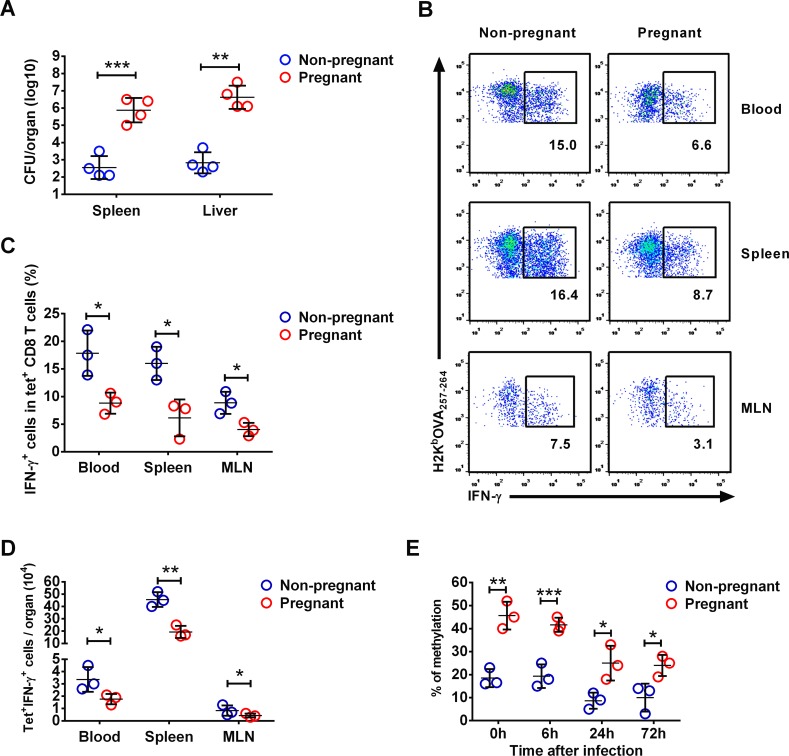
IFN-γ production by antigen-non-specific CD8 Tm cells in pregnant mice.Mice were immunized with rAdHuOVA 40 days before pregnancy, followed by LM infection. Bacterial CFU numbers in the spleen and the liver at 72 hours post infection are shown in (A). At 24 hours post infection, OVA antigen-specific CD8 Tm cells (CD8+H2KbOVA tetramer+) from peripheral blood, the spleen and MLN were stained with intracellular IFN-γ. Representative flow cytometry dot plot on intracellular IFN-γ staining in splenic CD8+ cells are shown in (B). Numbers in dot plots represent percentages of IFN-γ+ CD8+H2KbOVA tetramer+ cells in total CD8+H2KbOVA tetramer+ cells. Statistics of frequency (C) and absolute number (D) of IFN-γ-producing H2KbOVA tetramer+ CD8 Tm cells in various organs are shown. (E) Levels of IFN-γ gene methylation in splenic H2KbOVA tetramer+ CD8 Tm cells are shown at various time points before and within 72 hours after infection. Error bars represent mean±SD. Two-tailed unpaired Student’s t-test was used for statistical comparison between two groups. * P<0.05; ** P<0.01; *** P<0.001. Data in (A) are representatives of 2 independent experiments with n = 4 per group. Data in (B), (C) and (D) are representatives of 2 independent experiments with n = 3 per group. Data in (E) are representatives of 2 independent experiments with n = 3 per group.